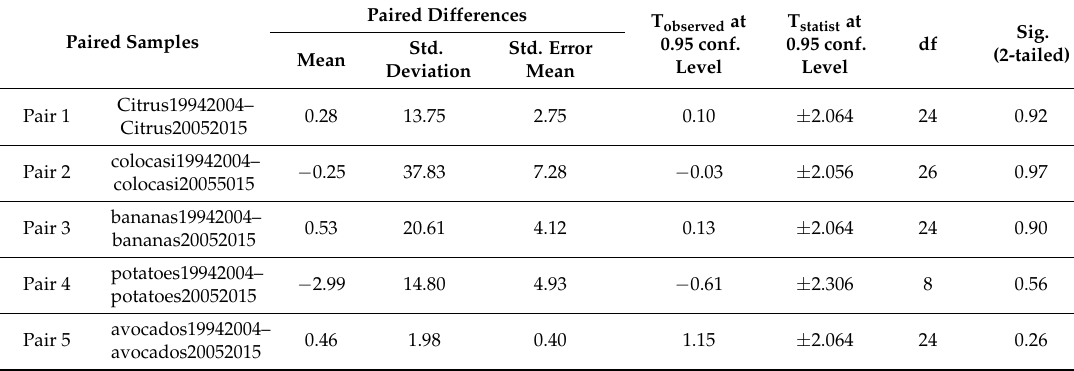
Table 5. Student’s t -test application for the paired values of 1994–2004 and 2005–2015.